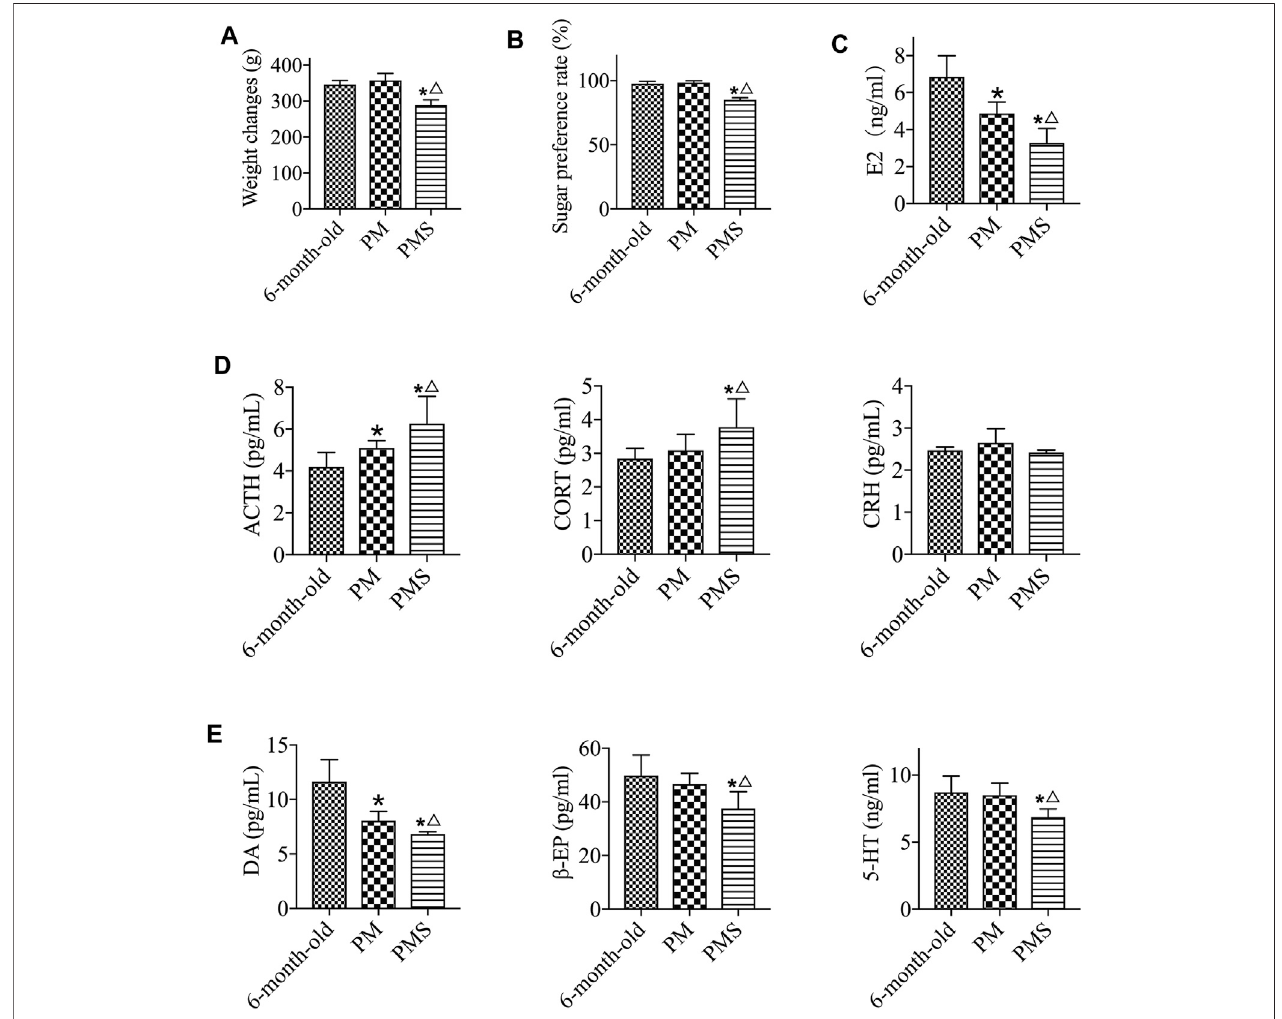
FIGURE 1 | PMS rats. (A) The body weights of 6-month-old, PM, and PMS rats. The PMS rats were with signi fi cant weight loss. (B) The PMS rats were of decreased sugar preference rate. (C) The level of estrogen in PMS rats was further decreased from that of perimenopausal rats. (D) The levels of ACTH and CORT in PMS rats were enhanced, while the level of CRH was not signi fi cantly altered. (E) The levels of β -EP, 5-HT, and DA were all lowered in PMS rats. “ * ” indicates the comparison with the 6-month-old rats [ p < 0.05 (*)]; “ △ ” indicates the comparison with the perimenopausal rats [ p < 0.05 ( △ )].